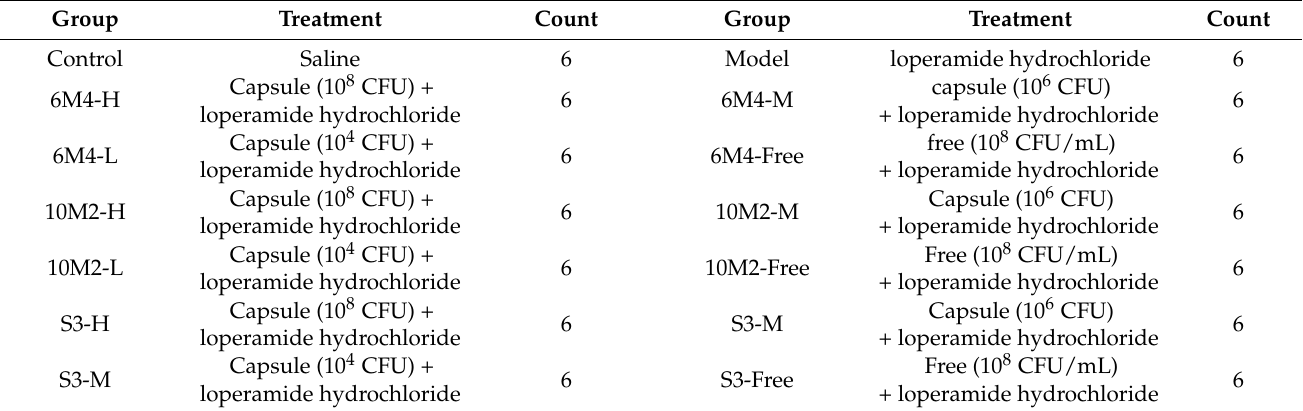
Table 2. Grouping of animal experiments and gavage treatment.